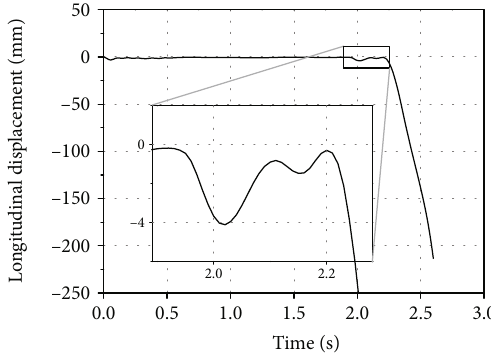
Figure 11: Longitudinal displacement of the center of mass of the missile under the fi xed platform.